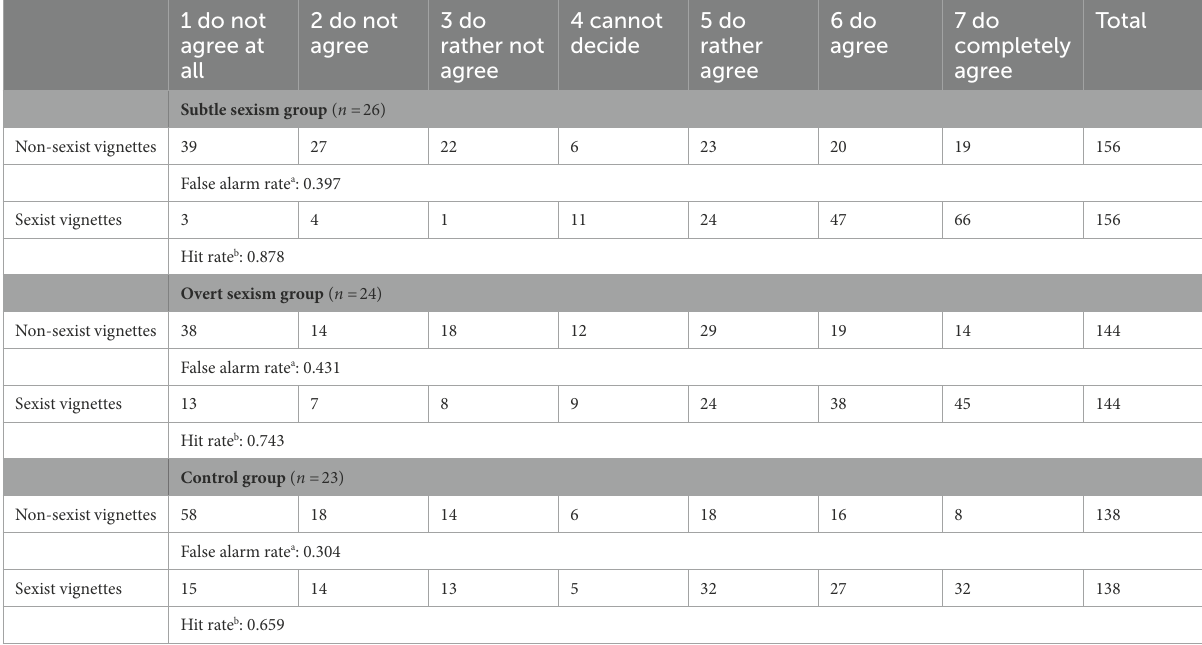
indicate how sexist they perceived the statement in each vignette to be on a 7-point Likert scale ( cf. Table 1). An odd-numbered scale was chosen to provide for one response option in case of uncertainty. Scale means were computed by averaging the participants’ ratings across the vignettes within each category of vignettes. Higher ratings of the sexist vignettes as sexist indicate higher sensitivity; lower ratings of the non-sexist vignettes indicate higher